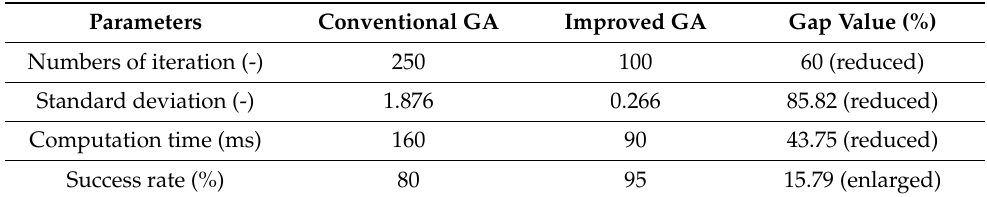
Table 14. Comparison of the observed parameters based on the GA types [148].